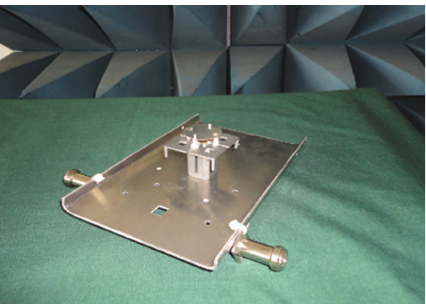
Figure 3: Simulated VSWR for different values of D and H3 .